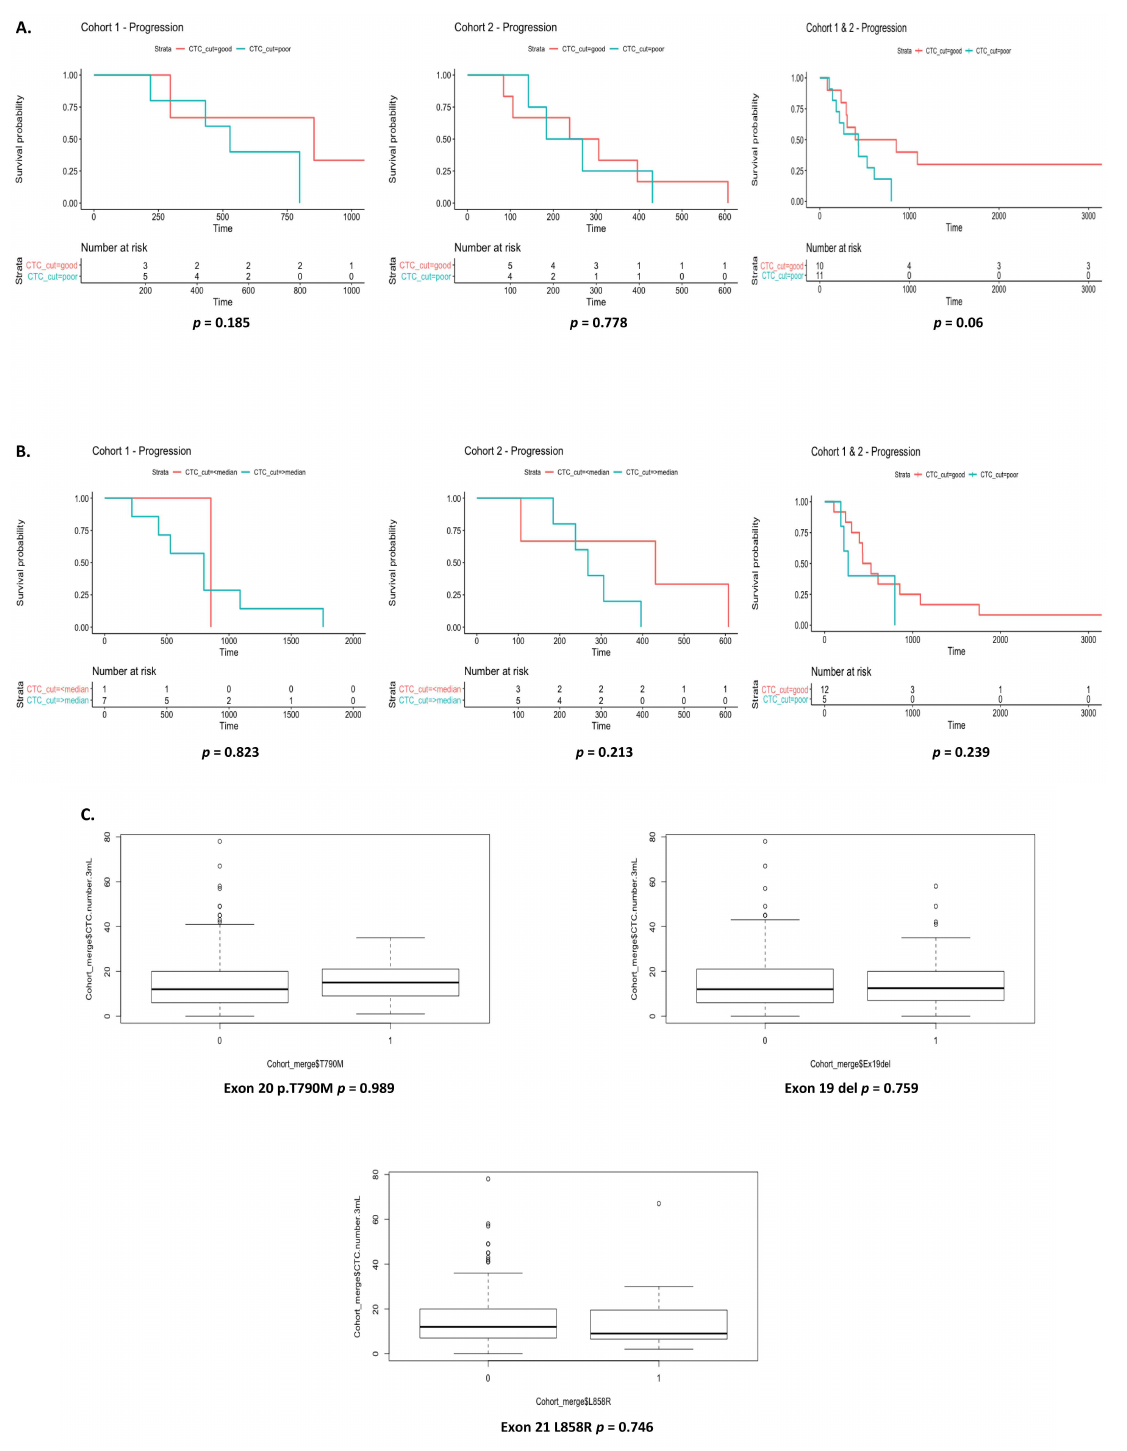
Figure 5. Assessment of CTC numbers and correlation with disease progression. At baseline ( A ) and at 6 months ( B ), the ability of CTC counts to predict disease progression was examined in each cohort individually and combined. No significant differences were observed in time to progression based on CTC counts below and above the median cut-off at baseline ( ≥ 16) or at 6 months ( ≥ 10). Univariate Cox proportional hazards analysis of time to progression and overall survival was used and Kaplan Meier survival plots represented. Comparison of mean CTC counts by EGFR mutation status (exon 20 p.T790M, exon 19del and exon 21 L858R) was examined at baseline in cohorts 1 and 2 combined using student’s t -tests ( C